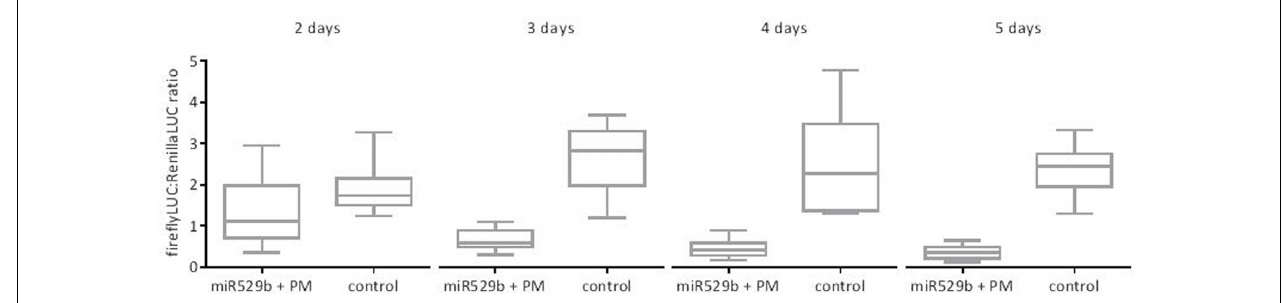
FIGURE 5 | Dual LUC assays reporting miR529b-mediated repression of a PM target within the firefly reporter gene construct, after a range of incubation periods post co-agroinfiltration. The controls consist of assays where the miR529b precursor construct culture was replaced with a construct that is predicted to form a secondary structure but does not target the mir529b PM sequence. The results are depicted as box and whisker plots, with interquartile range boxes and min/max whiskers ( n = 12).